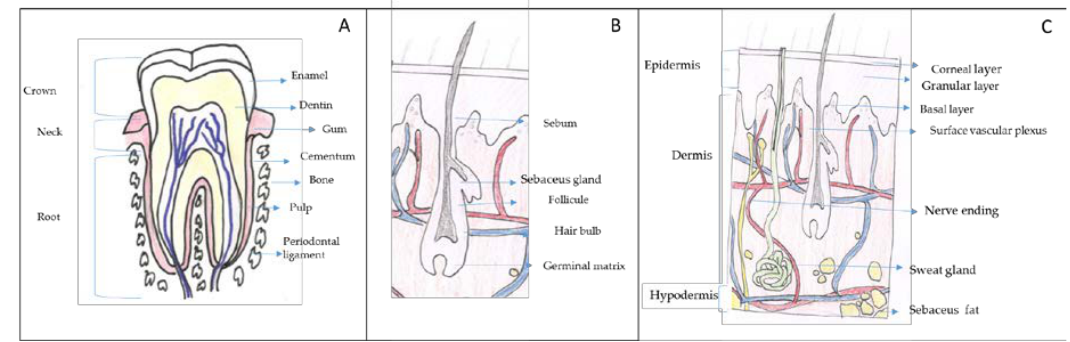
Figure 1. Target organs for cosmetic and cosmeceutical products. ( A ) Gums and tooth, ( B ) hair and ( C ) skin. Adapted from Wikipedia Commons (authors: KDS4444, Human tooth diagram-en.svg CC-BY-SA 4.0, Madhero88, Skinlayers.svg CC-BY-SA 3.0).